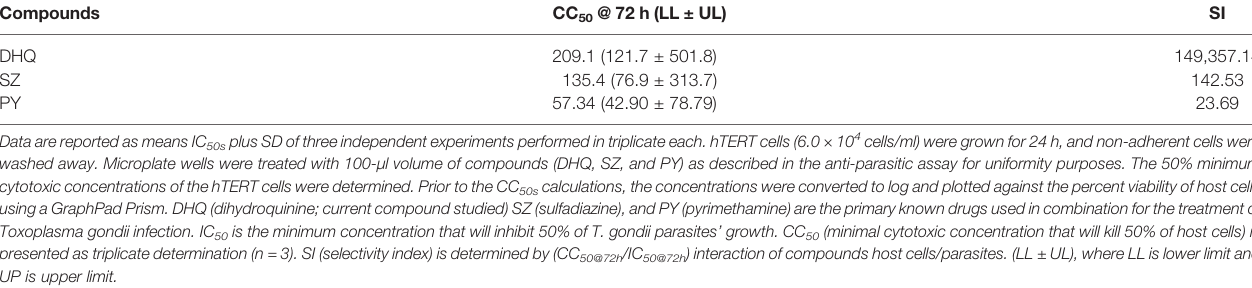
TABLE 2 | Mean CC 50s (µM) of DHQ, SZ, and PY on hTERT cells. Compounds DHQ